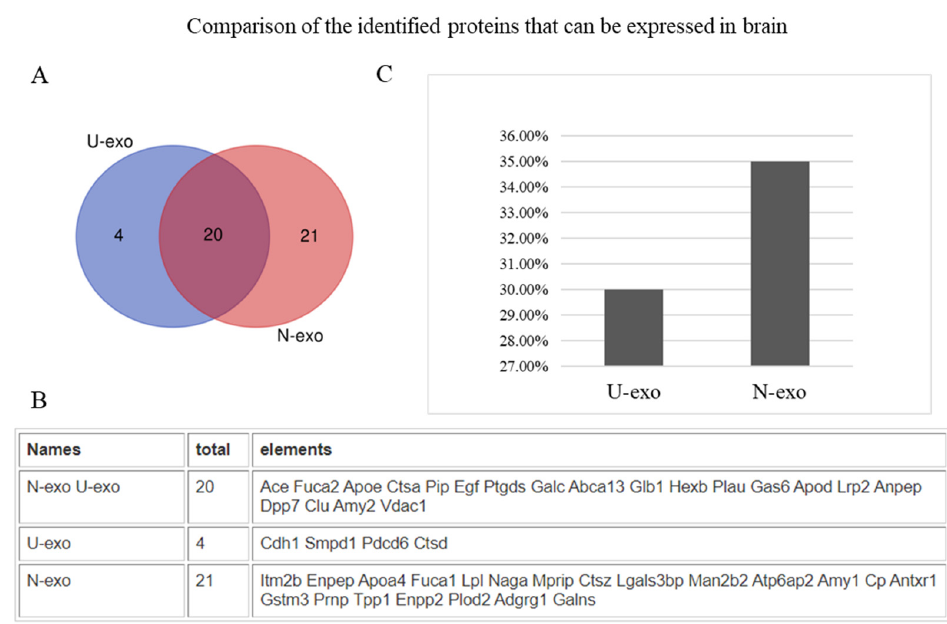
Figure 4. The comparison of the identified proteins which can be expressed in the brain in both U-exo and N-exo. ( A ) Venn diagram showing the identified proteins which can be expressed in the brain in both U-exo and N-exo and ( B ) corresponding proteins. ( C ) The percentage of the identified proteins which can be expressed in the brain to the total identified proteins. U-exo: urine exosomes. N-exo: neuron-derived exosomes. Table 3. Neuron markers in U-exo and N-exo. Gene Symbol